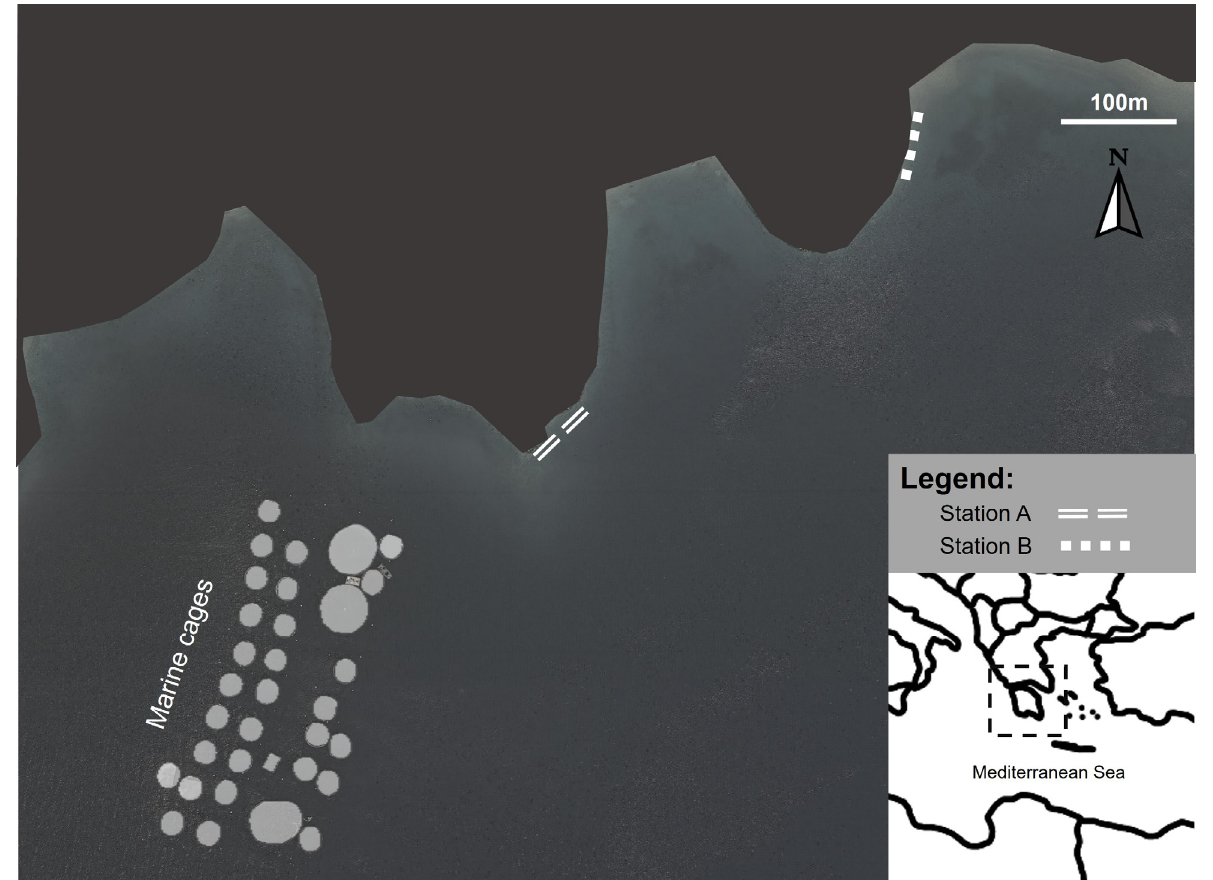
Figure 1. Sampling site location in the Aegean Sea, showing station A at a 250 m from the cages (37°27 ′ 4.03 ″ N, 23°4 ′ 10.37 ″ E) and station B at 650 m from the cages (37°27 ′ 9.49 ″ N, 23°4 ′ 19.79 ″ E).